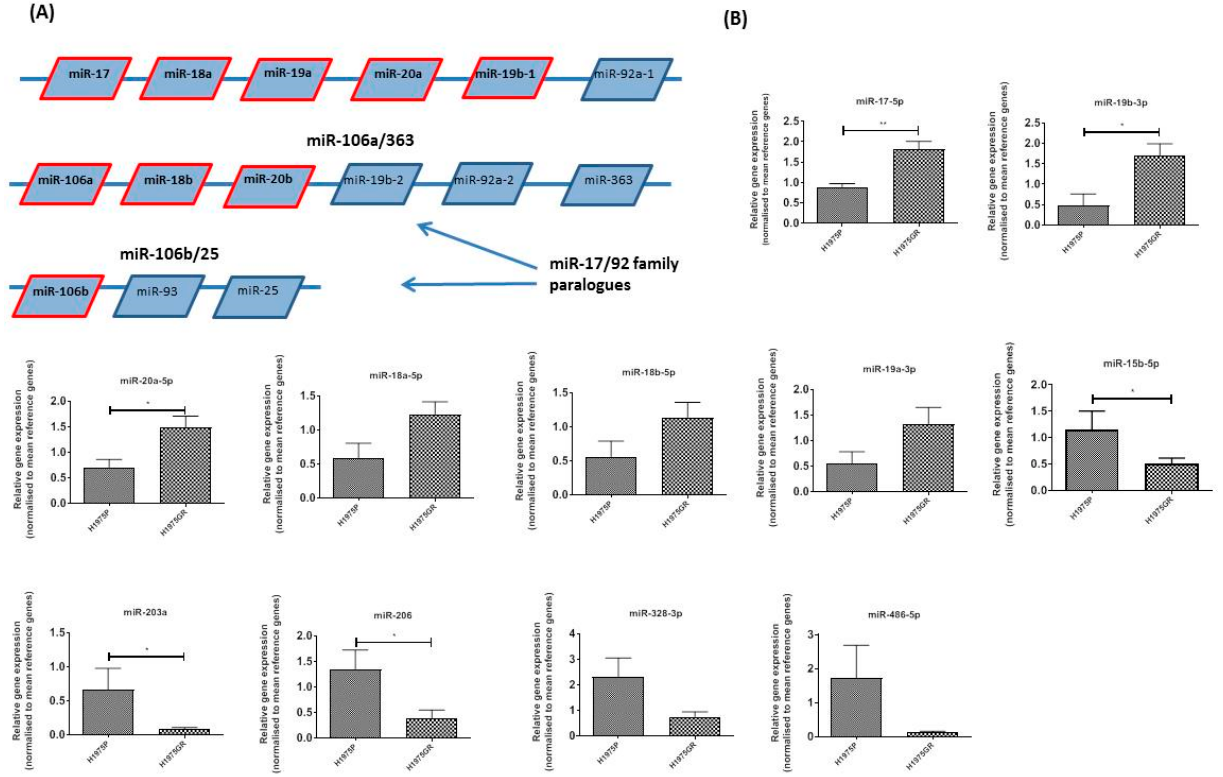
Figure 8. Characterization of PIM1 and MYC associated microRNA signature in PI3K/mTOR inhibitor resistant H1975GR. Small RNA preparations, including miRNAs from both H1975GR and H1975P cells were tested in duplicate wells using a custom miRNA expression array ( n = 3) containing 19 genes plus endogenous control genes. ( A ) Nine genes within the miR-17/92 cluster and paralogues were included in the custom array and there was a significant upregulation of ( B ) miR-17-5p ( p < 0.01), miR-19b-3p ( p < 0.05) and miR-20a-5p ( p < 0.05) in the H1975GR cells compared to H1975P. There was a similar upregulation for a number of miRNAs in this cluster; miR-18a-5p ( p = 0.0876), miR-18b-5p ( p = 0.1467) and miR-19a-3p ( p = 0.1230) in H1975GR. There was a downregulation of miR15b-5p ( p < 0.05), miR-203a, miR206 ( p < 0.05), miR328-3p and miR486-5p (both p = 0.1068) in H1975GR compared to age matched control cells, H1975P. * p < 0.05, ** p < 0.01, paired student t -test, n =